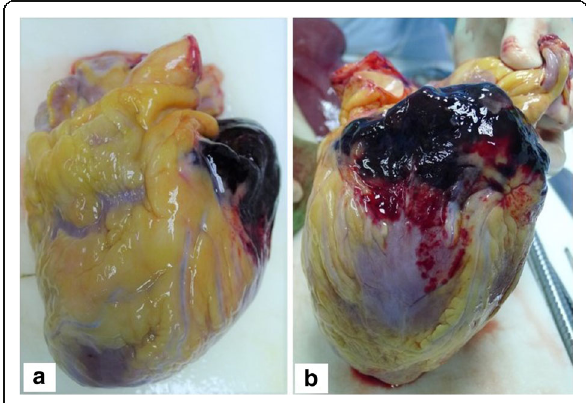
Fig. 2 Epicardial haemorrhage around the left circumflex artery region. a Anterior view. b Top view